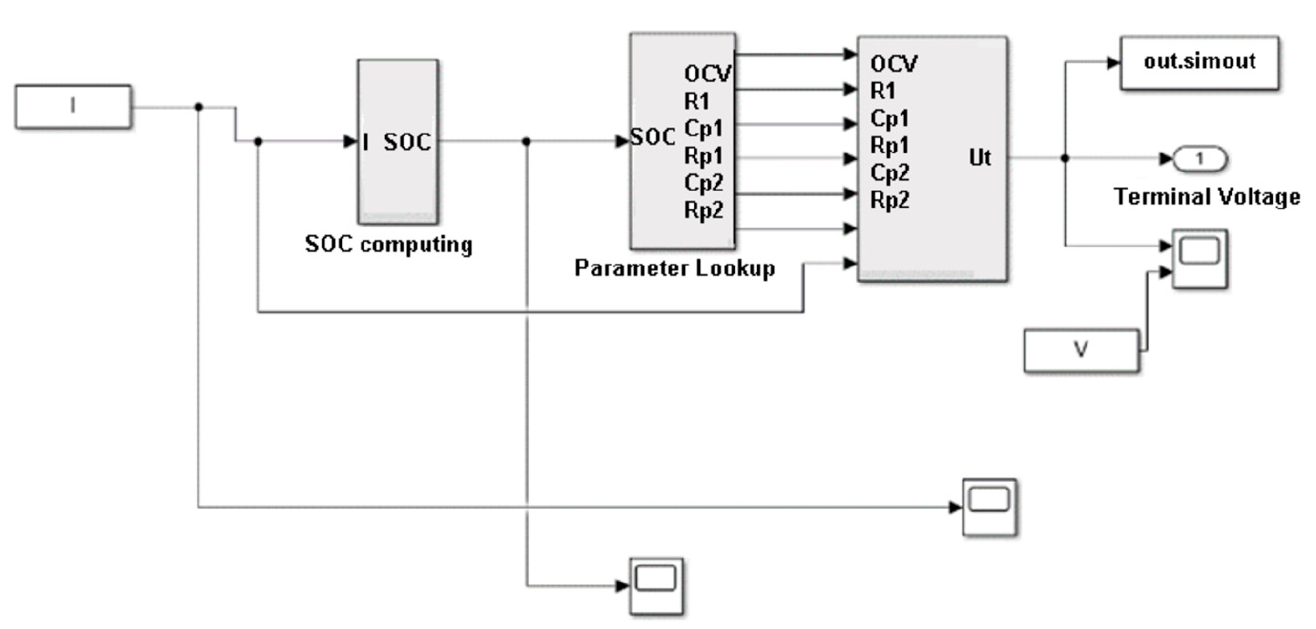
Figure 3. Terminal voltage calculation submodule of the second-order RC circuit.